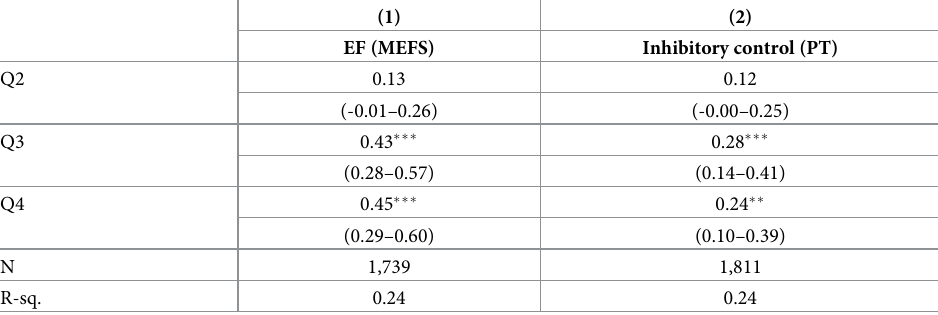
Table 3. Average SES effects in executive function and inhibitory